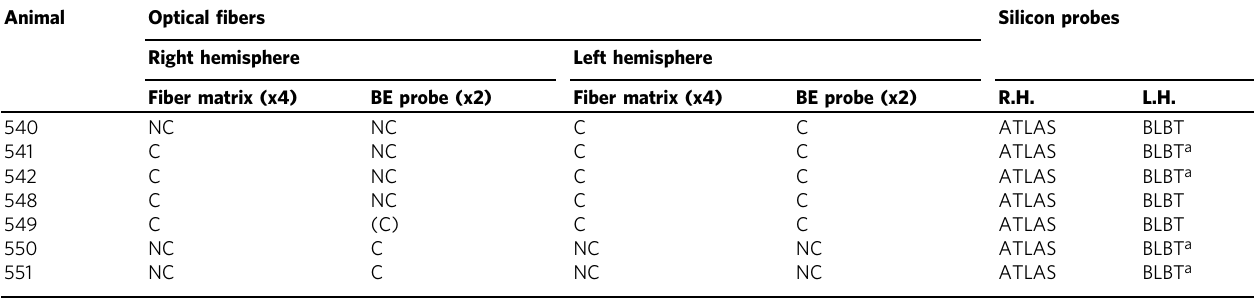
NC not coated, C coated, R.H. right hemisphere, L.H. left hemisphere. a Large fl uctuations (>1mV) in the extracellular signal fl uctuations. These fl uctuations were most likely due to reuse of the ZIF-clip connector, and those probes were excluded from further analyses. (C) = In one BE probe, the fi bers were assumed to be defective because there was no PVR. The ATLAS and BLBT probes are Michigan-style silicon-based intracortical probes. The BLBT probe was produced as a part of BrainLinks-BrainTools.